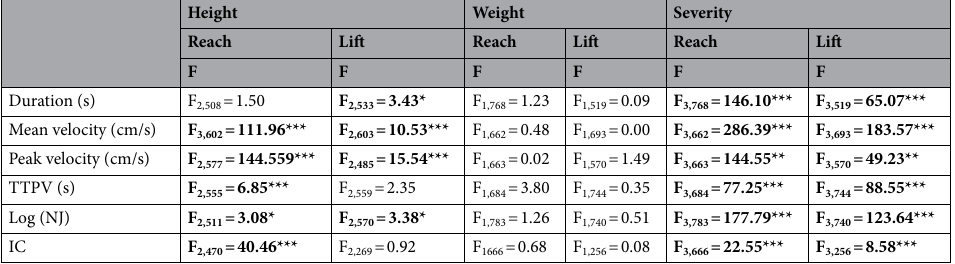
Table 4. Mean values of kinematic variables: effect of height, weight and severity. Summary of the kinematic results. Bolded values denote a significant difference between the groups. Height, Weight, Severity: list the F value for the differences across this parameter; Asterisks denote the p value: * p ≤ 0.05, ** p ≤ 0.01, *** p ≤ 0.001. mm Millimeters, s Seconds, TTPV Time to-peak-velocity, NJ Normalized Jerk, IC Index of